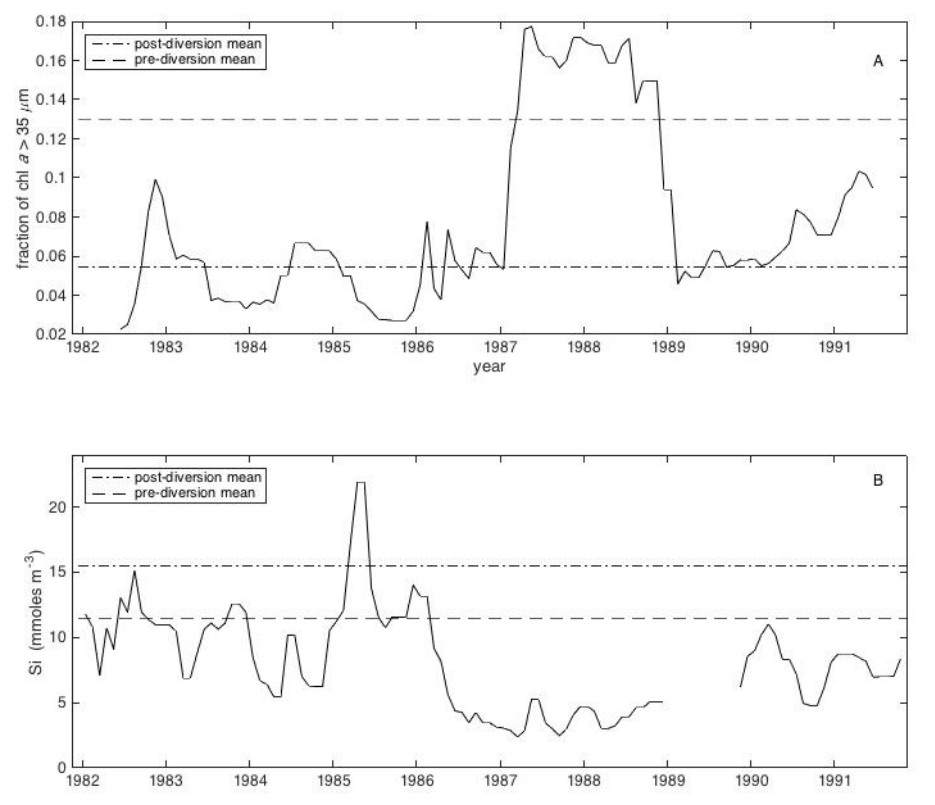
Figure 3. ( A ) The six-month running means of the fraction of chlorophyll a retained on a 35-micron filter from late 1982 through late 1991 in the southeast sector of Kaneohe Bay and ( B ) three-month running means of silicate concentrations in the southeast sector of Kaneohe Bay. Tick marks as in Figure 2.